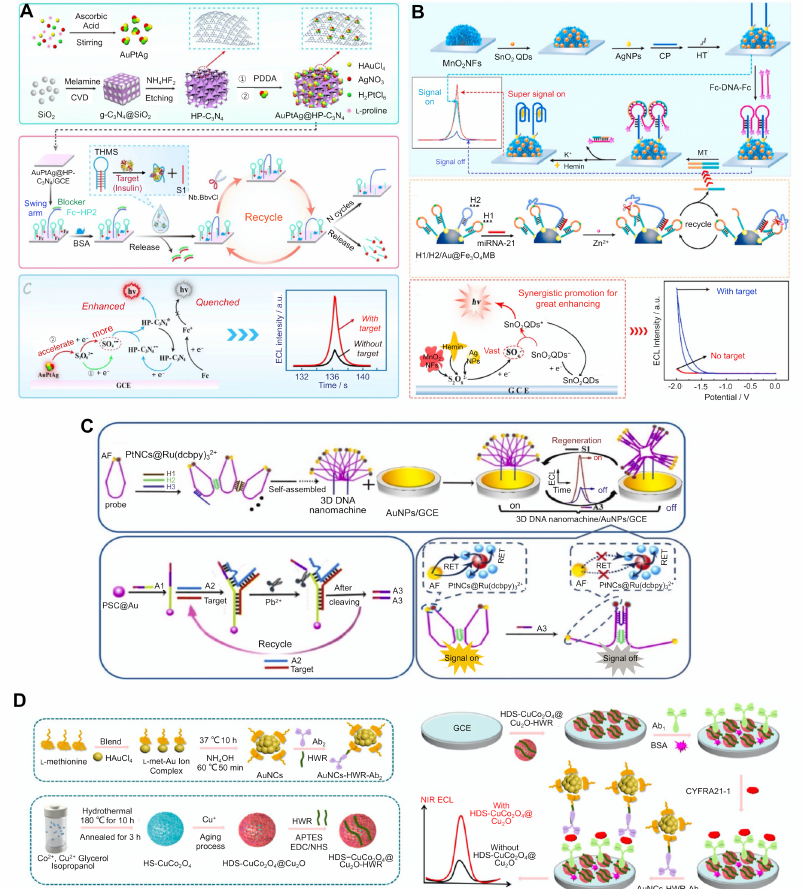
Figure 2. An ECL-based sensing strategy and technology for the sensitive detection of biomarkers. ( A ) Insulin detection system combined with a co-reaction accelerator-involved redox reaction (reprinted with permission from [22], © 2019, Elsevier). ( B ) miRNA-21 detection system combined with a multiple co-reaction accelerator reaction and a 3D DNA walker-mediated signal amplifi- cation method (reprinted with permission from [31], © 2020, Elsevier). ( C ) miRNA-141 detection system combined with multiple ECL-RET reactions and a Pb 2+ -dependent DNAzyme-assisted target- recycling amplification (reprinted with permission from [38], © 2020, Elsevier). ( D ) Alpha-fetoprotein antigen (AFP) detection system using CuNCs as a near-infrared (NIR)-ECL luminophore and K 2 S 2 O 8 as a co-reactant (reprinted with permission from [41], © 2022, American Chemical Society). CVD, chemical vapour deposition; HP, hollow porous; GCE, glassy carbon electrode; BSA, bovine serum al- bumin; THMS, triple-helix molecular switch; NF, nanoflower; QD, quantum dot; MB, magnetic bead; GCE, glassy carbon electrode; EDC, 1-ethyl-3-(3-dimethylaminopropyl) carbodiimide hydrochlo- ride; NHS, N-hydroxysuccinimide; HWR, Fc-specific heptapeptide with HWRGWVC sequence; HS, hollow